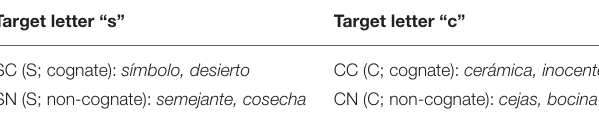
TABLE 2 | Participant demographic information. TABLE 3 | Examples of experimental